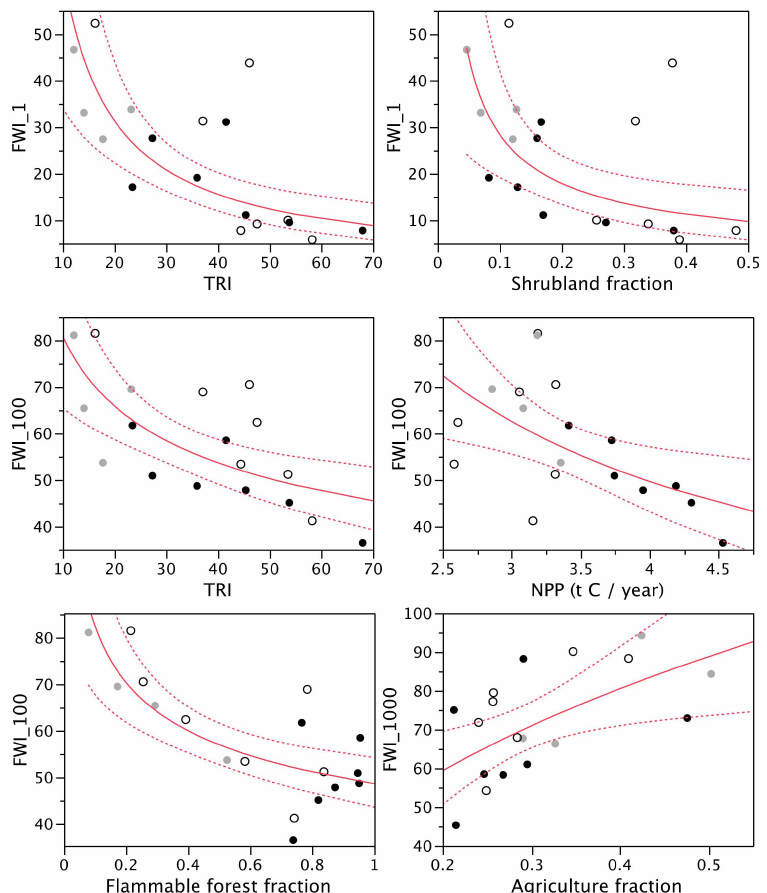
Figure 3. Selected relationships of the form y = a × x b between regional FWI thresholds for the occurrence of fires ≥ 1 (FWI_1), ≥ 100 (FWI_100), and ≥ 1000 (FWI_1000) ha and biophysical variables, with 95% confidence intervals. Models were fitted on log-transformed variables. Black, white, and grey circles correspond to the NCW, NCE, and S supra regions of Portugal.